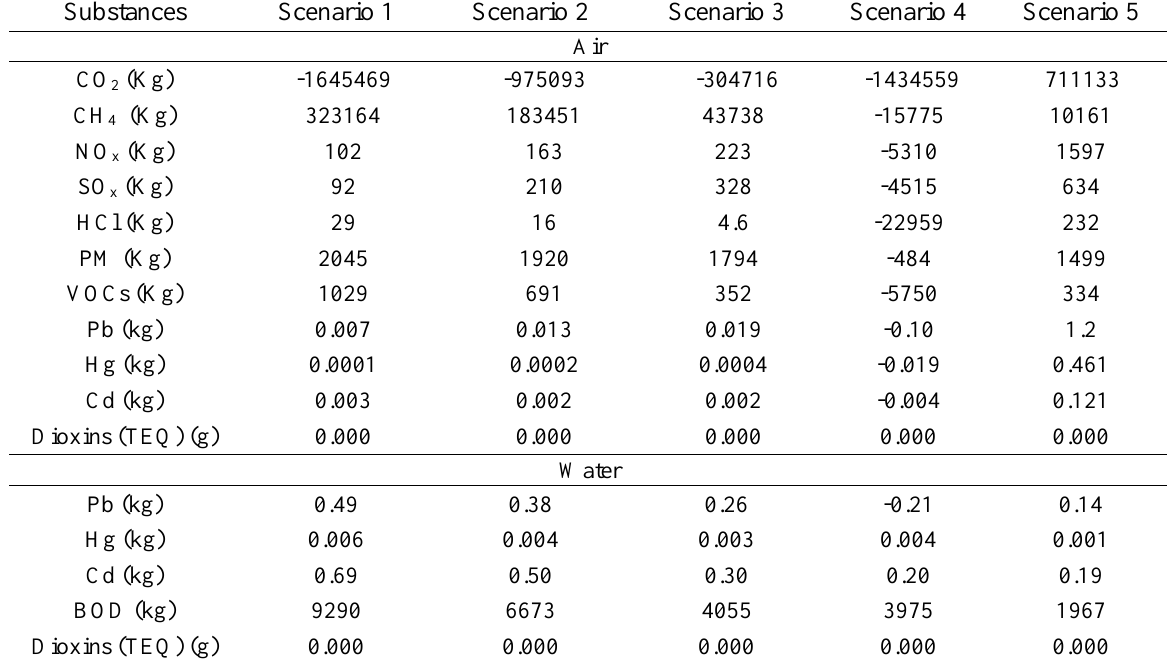
Table 3. The inventory results of each scenario (per day)